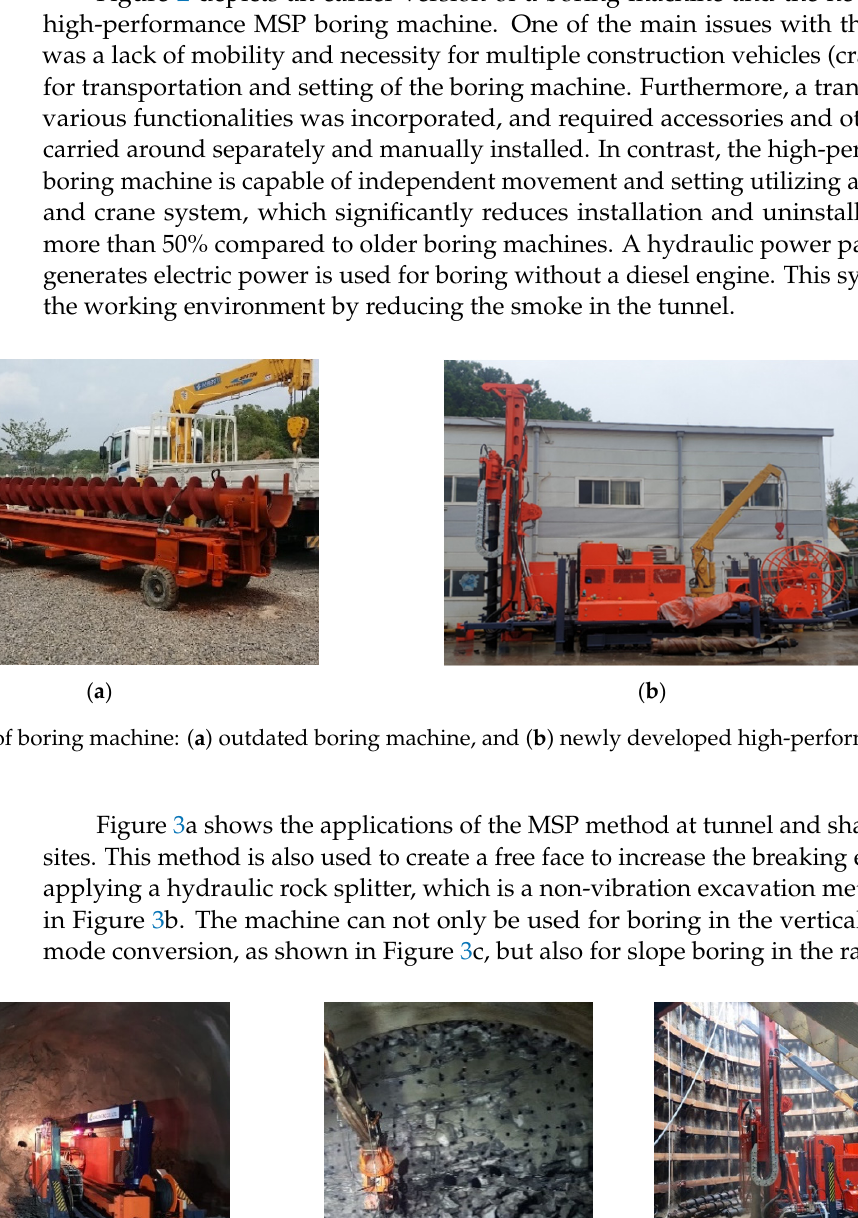
Figure 1. Comparison of the principle between ( a ) general blasting method and ( b ) multi-setting smart-investigation of the ground and pre-large hole boring (MSP) method.